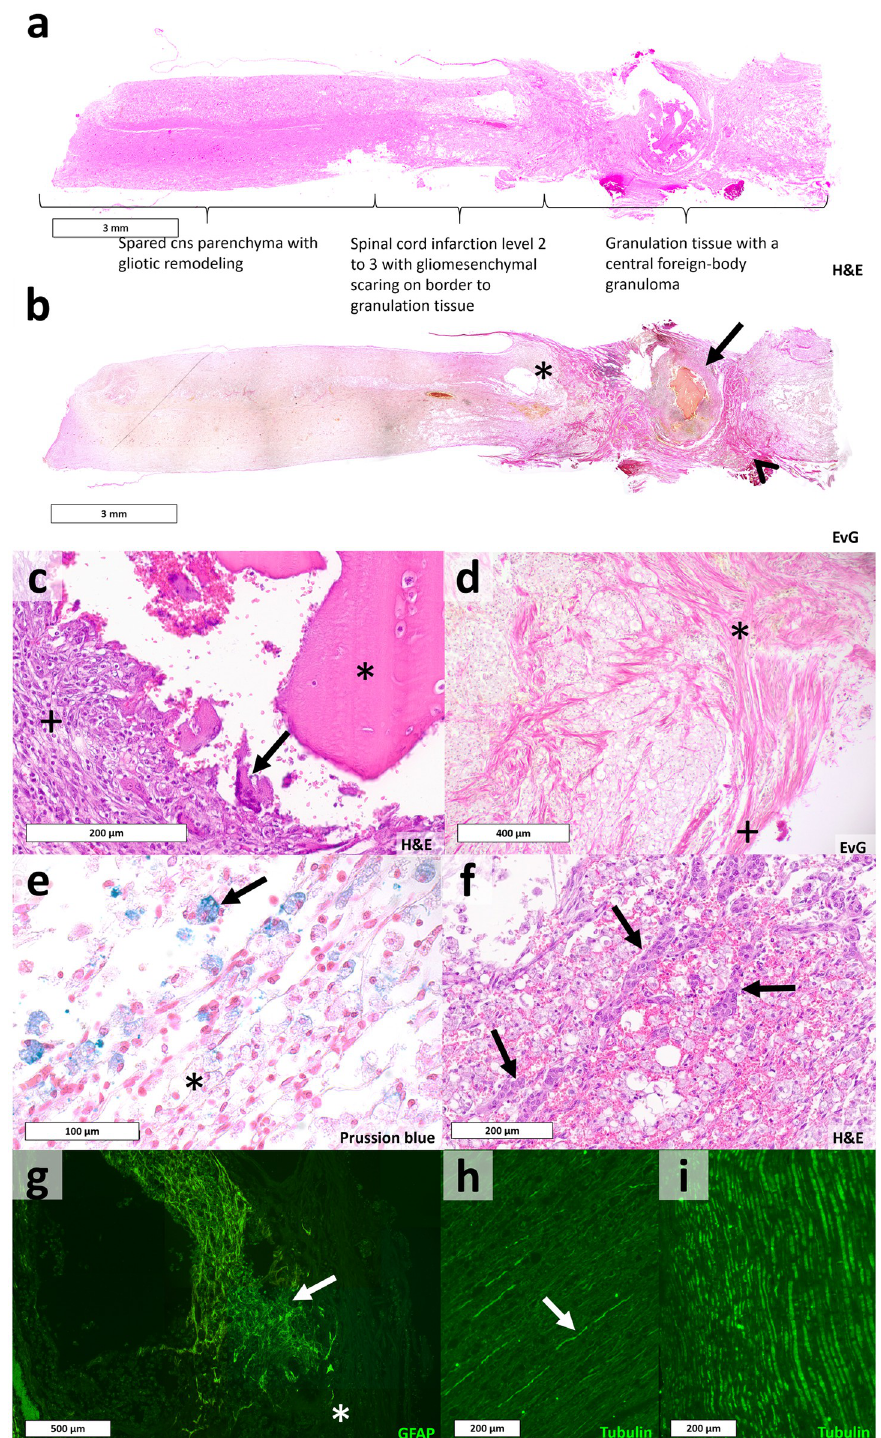
Fig 4. Foreign body reaction in-vivo. A (H&E) and b (EvG) display overview images of the spinal cord, which can be partitioned into three morphological sections. The foreign-body granuloma (b—arrow) and the migration of fibroblasts (b–arrowhead) are visible in b. In c (H&E) polynuclear foreign-body giant cells (c–arrow), epithelioid cells (c- plus), and the fibrin part of the initially placed implant (c–star) can be seen inside the foreign-body granuloma (b– arrow). D (EvG) is a magnification of b showing collagen (d–star) formed by migrating fibroblasts as a part of